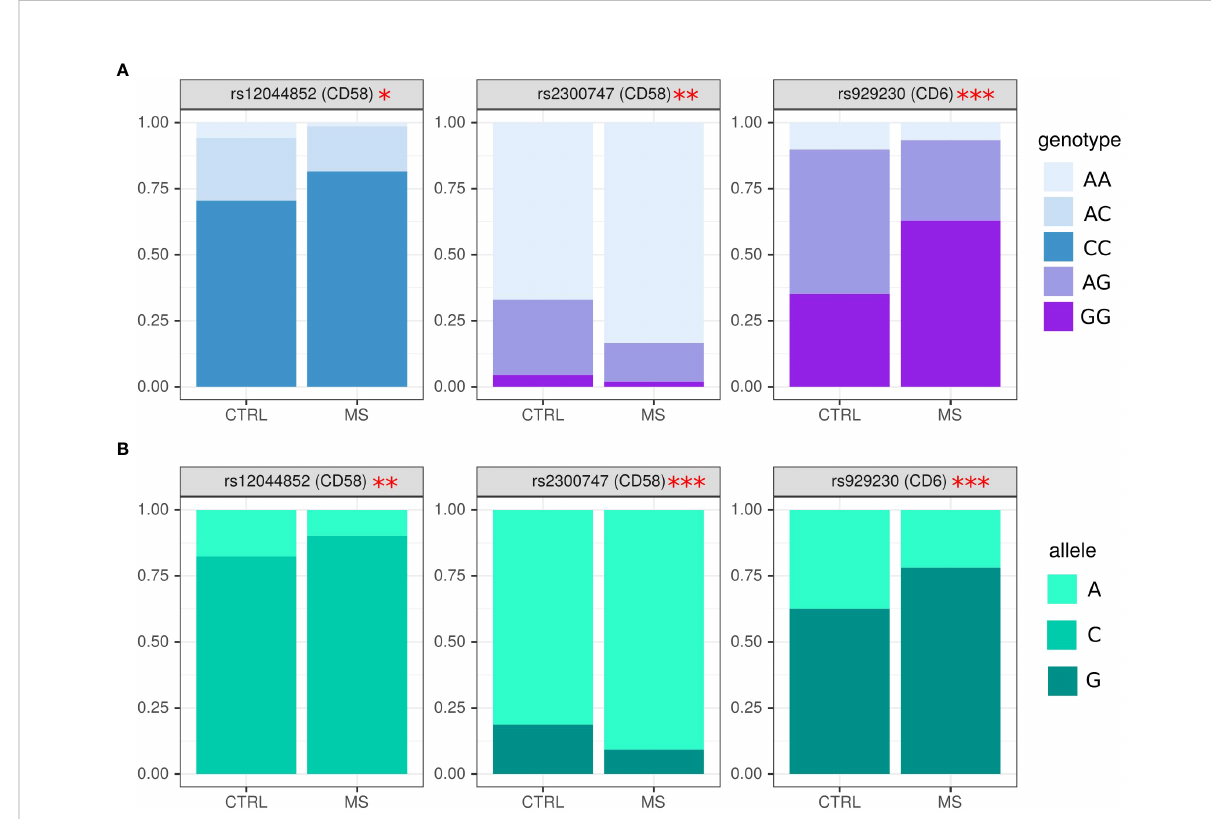
FIGURE 1 Analysis of genotype and allele frequency in rs2300747, rs929230 and rs12044852 SNPs in MS and controls. (A) – genotypes, (B) – alleles. SNPs analysis was done by AS-PCR. Data is presented as proportion of representation of genotype/allele. There were 151 MS and 70 controls samples used for the analysis. The analysis was done using Fisher ’ s exact test. *** - p<0.005, ** - p<0.05, * -